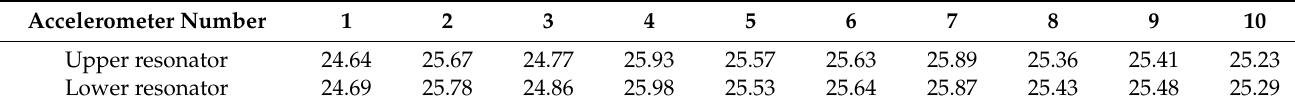
Table 2. Unloaded resonant frequency of accelerometer resonator (kHz).